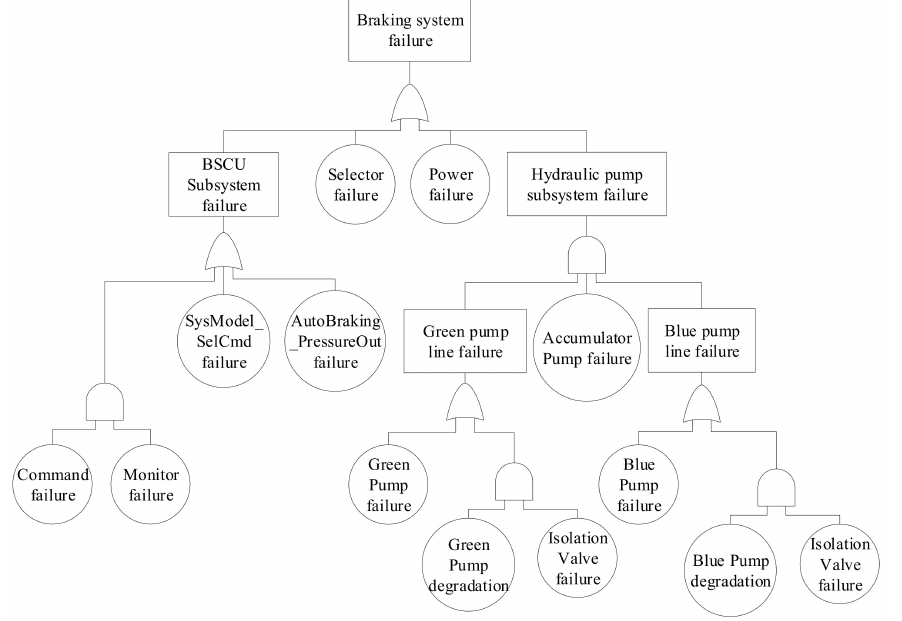
Figure 9. Fault tree of brake